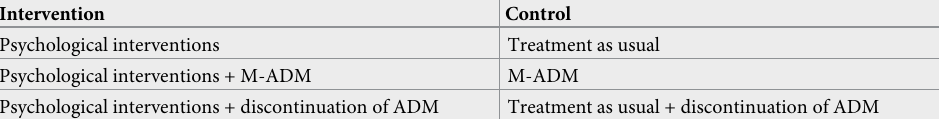
Table 1. Overview of comparisons of interventions and control groups, for anxiety and depression studies with different follow-up durations. Intervention Control Psychological interventions Treatment as usual Psychological interventions + M-ADM M-ADM Psychological interventions + discontinuation of ADM Treatment as usual + discontinuation of ADM Note: psychological interventions = cognitive behavioural therapy (CBT), cognitive therapy (CT), preventive cognitive therapy (PCT), internet-based CBT, continuation cognitive therapy (C-CT), maintenance cognitive behavioural therapy (M-CBT), mobile cognitive therapy, mindfulness-based cognitive therapy (MBCT), interpersonal psychotherapy (IPT), (cognitive) psychoeducation ((C)PE) with therapeutic components, cognitive- behavioural analysis system of psychotherapy (CBASP); M-ADM = maintenance antidepressant medication; treatment as usual = no treatment, evaluation only, monitoring, non-specific